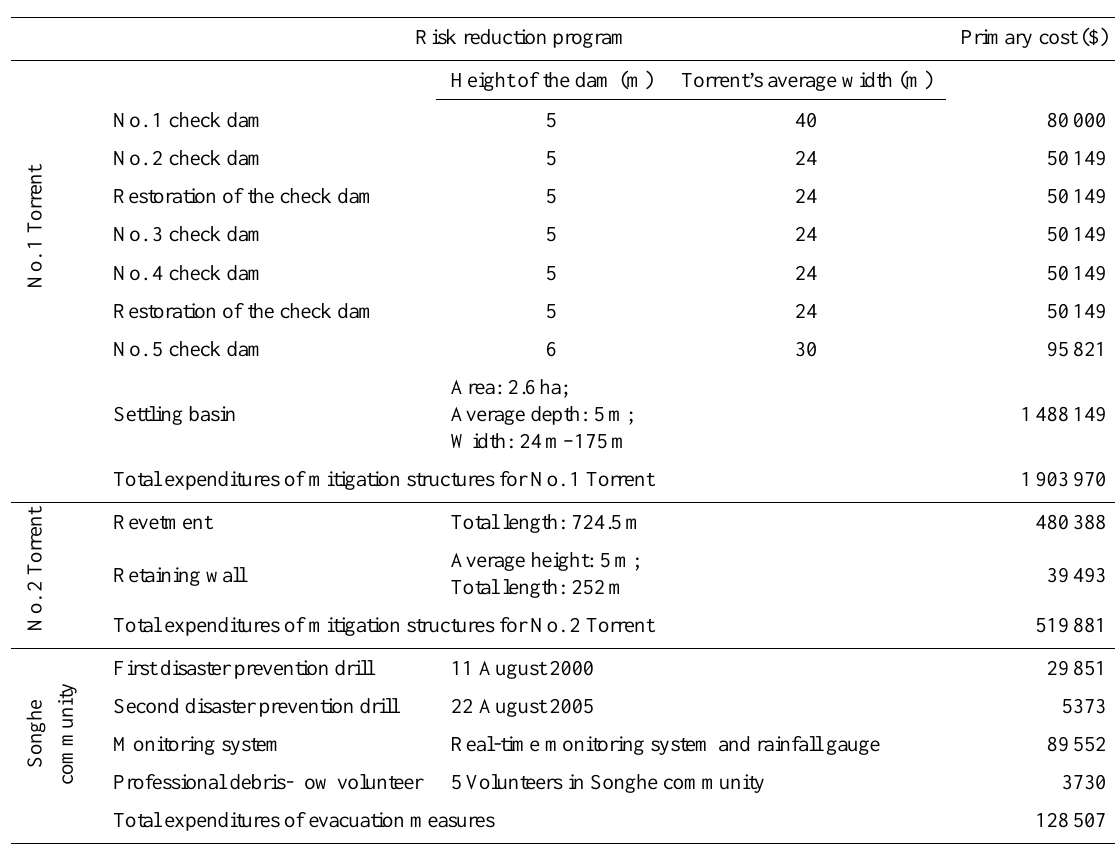
Table 5. Risk reduction program for debris flows in Songhe community.